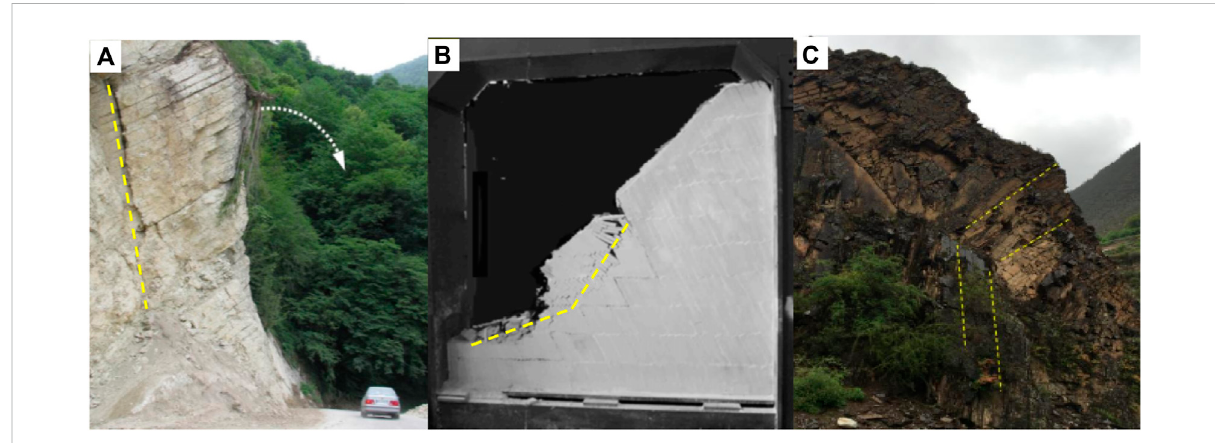
FIGURE 2 Flexural-topplingfailuresobservedin fi eldinvestigationsandlaboratorytests: (A) Galandroodmineslope; (B) themodelslope; (C) Bankslopeof Zhala Hydropower